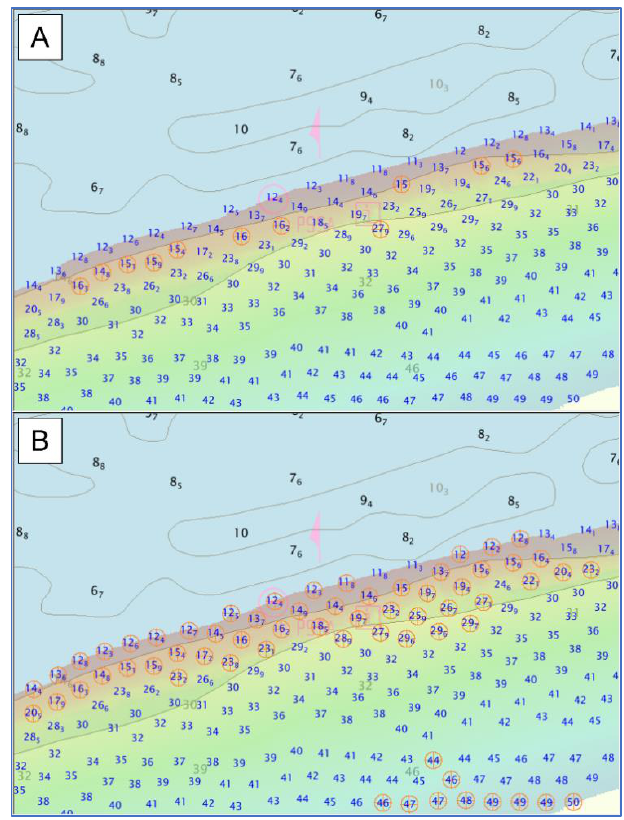
Figure 14. Example of the application of the Shoalest Depth testing method (i.e., the traditional flat triangle test ) ( A ) and the Tilted Triangle testing method ( B ). The 5.1-m survey soundings (in dark yellow) are only flagged by the Tilted Triangle testing method when compared to the chart soundings (in purple).